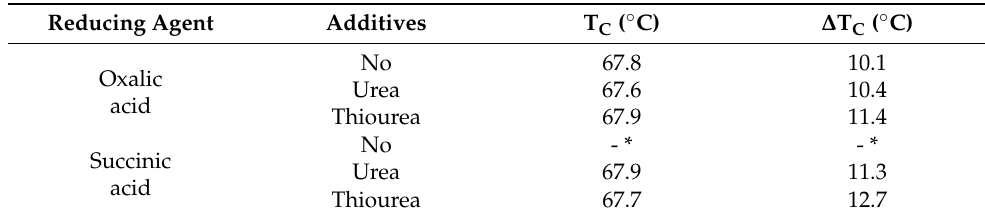
Figure 4. Thermochromic transition curves obtained by differential scanning calorimetry of hy- drothermally synthesized VO 2 in the form of powder using ( a ) oxalic acid and ( b ) the succinic acid, as reducing agents, with and without the presence of additives. Table 3. Calculated thermochromic properties from the DSC curves of synthesized ‘final’